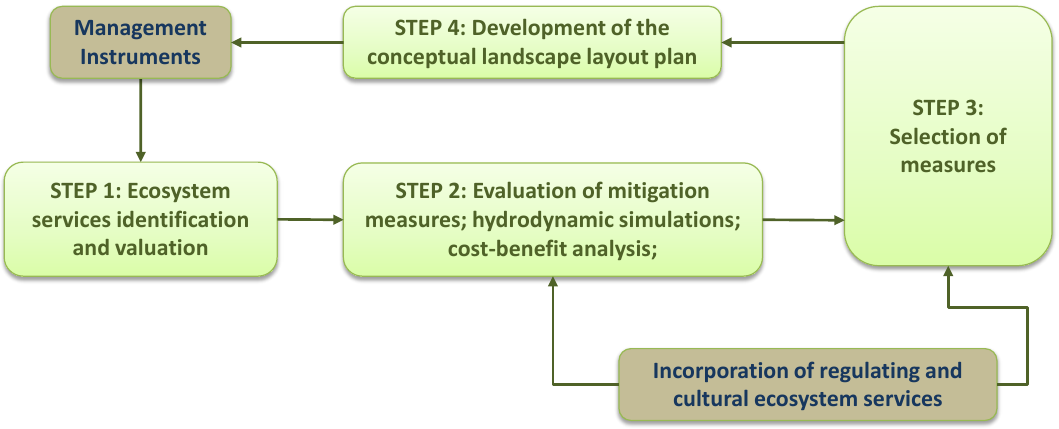
Figure 2. Illustration of the methodological framework that combines ecosystem services with cost-benefit analysis, CBA (or benefit-cost analysis, BCA), for selection of green and grey infrastructure for flood protection in a cultural setting.